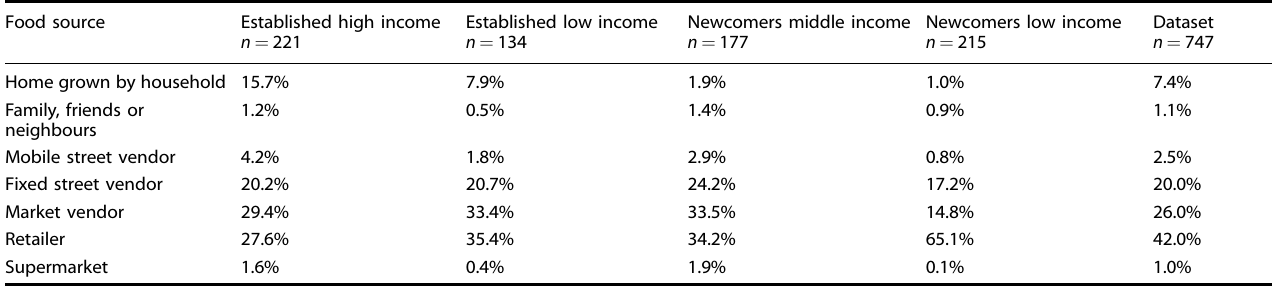
Table 1. Food sources where surveyed households ( n = 747) of different SECs obtain their fi ve staple foods. Food